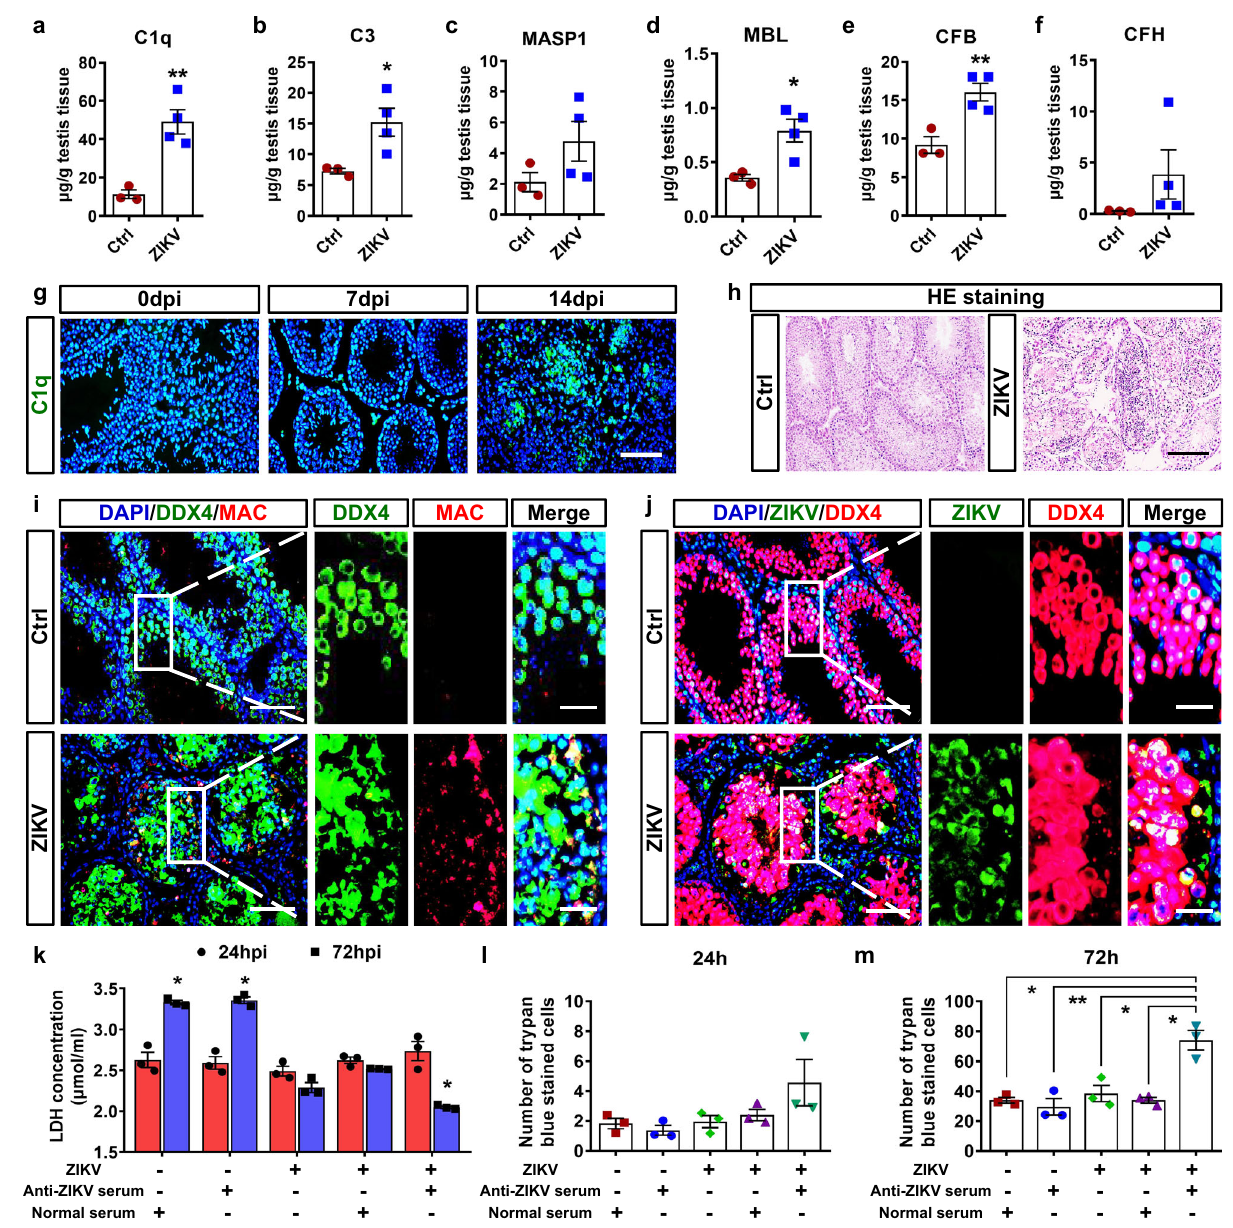
Fig. 4 | The activation of complement system led to the damage of spermato- genic cells. a – f Concentration of complement components in testes from control or ZIKV-infected A6 male mice at 14 dpi were analyzed by ELISA. Results were shown as means±SEM ( n =3 mice for ctrl and 4 mice for ZIKV-infected) and ana- lyzedusingthetwo-sidedStudent ’ s t test.* p <0.05,** p <0.01. g Thedistributionof C1q was analyzed by IFA in ZIKV-infected testes from A6 mice at 0, 7, and 14 dpi. Scalebar,25 μ m. h